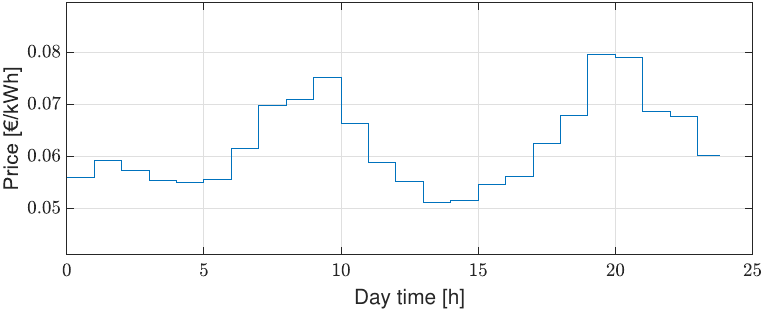
Figure 7. Example 3. Prices of import from the grid in day 10. The unit cost of sheddable demand and steerable generation are considered constant throughout the day and their values are 0.09 e /kWh and 0.07 e /kWh, respectively. Concerning the simulation results, the procedure based on the heuristic assignment provides an average community daily cost of 114.16 e , whereas the total cost of all the entities acting individually would be 129.48 e . Energy flows and community prices for a given day are reported in Figure 8.